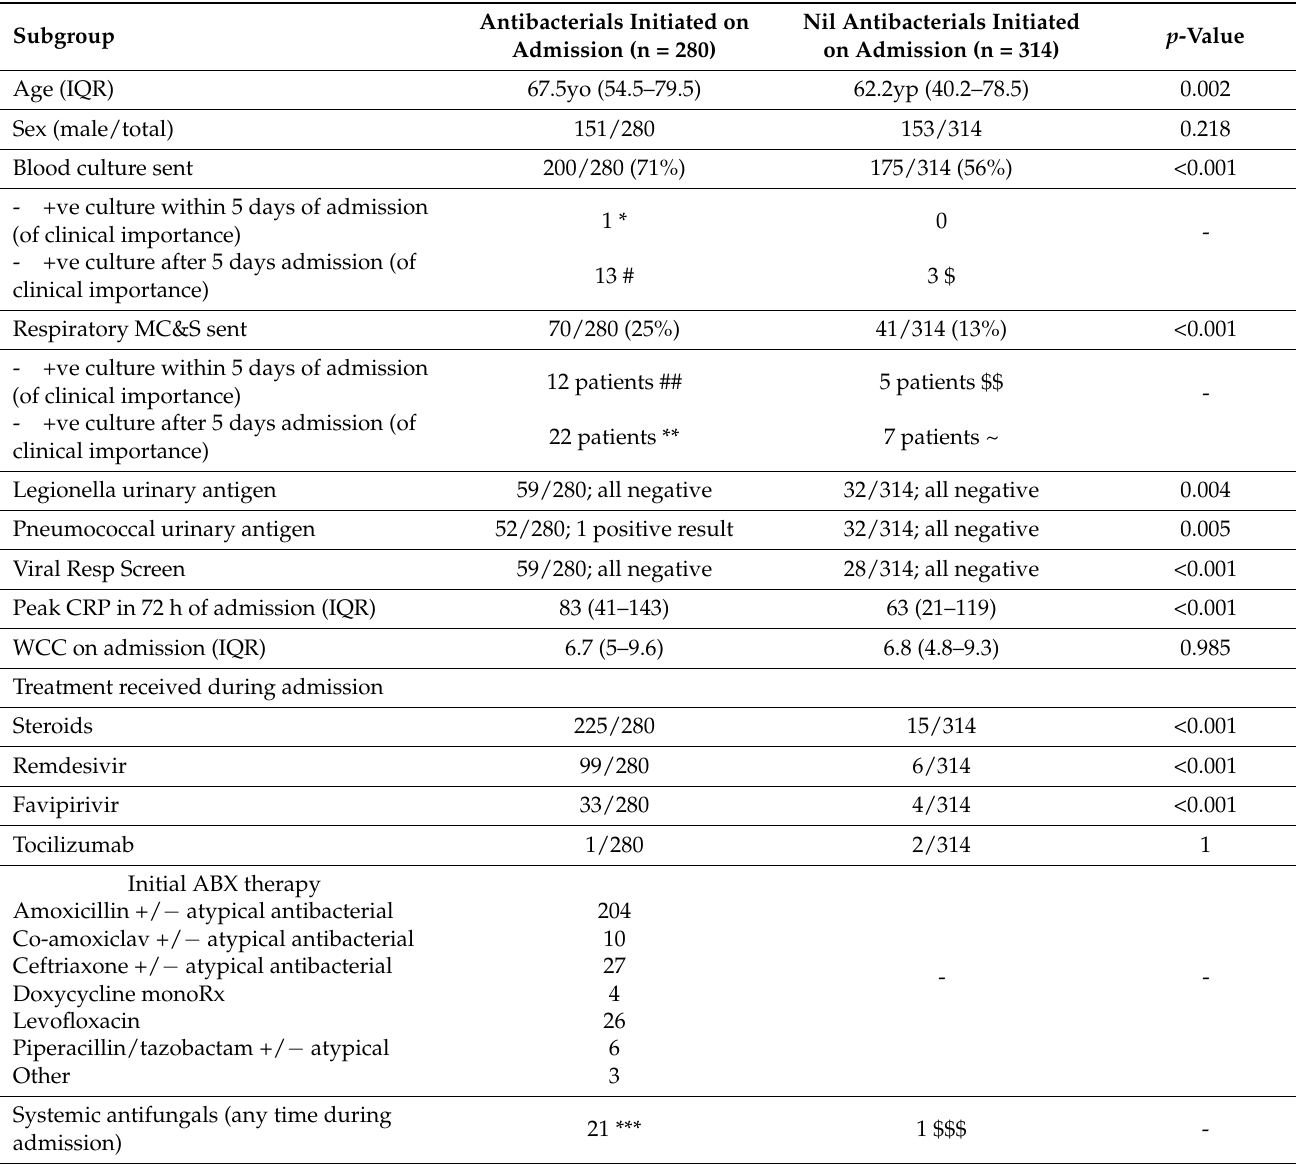
Table 1. COVID-19 patient and infection-related characteristics, London, December 2020–February 2021 (UK wave